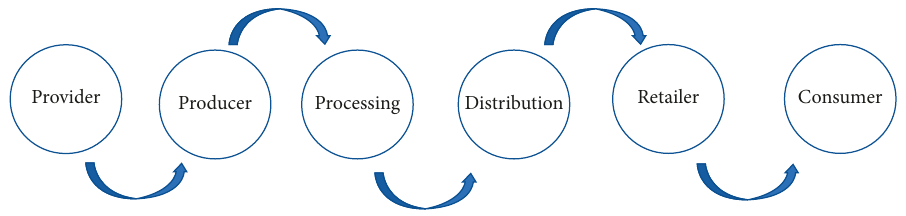
Figure 3: Blockchain in agriculture.